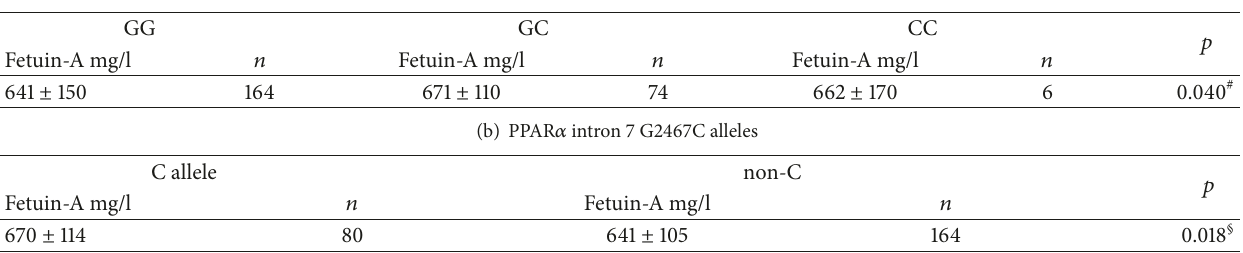
Table 3: Serum fetuin-A concentrations in individuals with different PPAR 𝛼 intron 7 G2467C SNP polymorphisms and alleles.